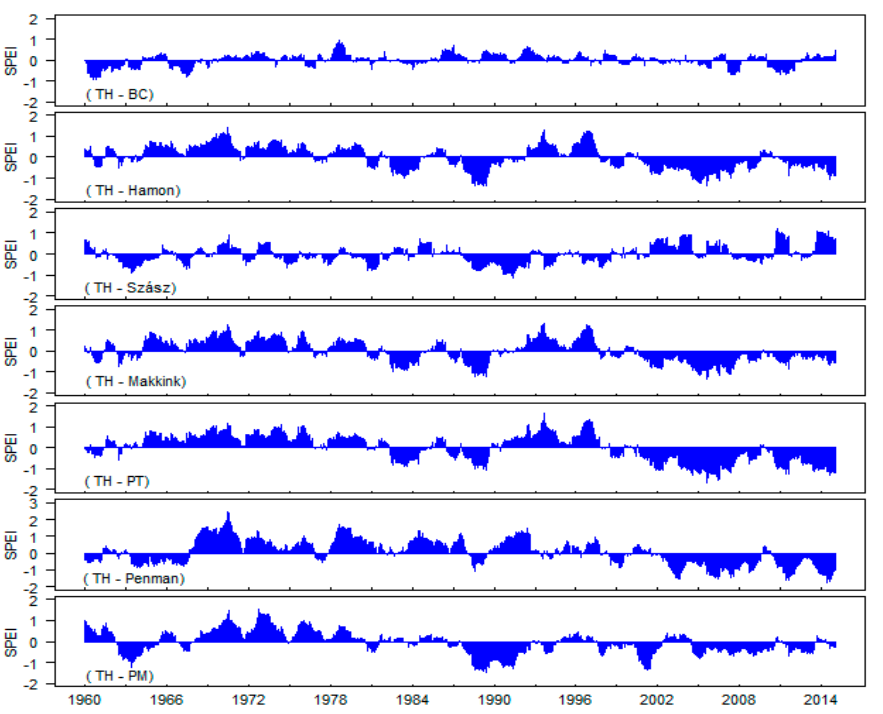
Figure 7. Differences between the SPEI series using the eight different PET models at YC station (taking TH as the benchmark